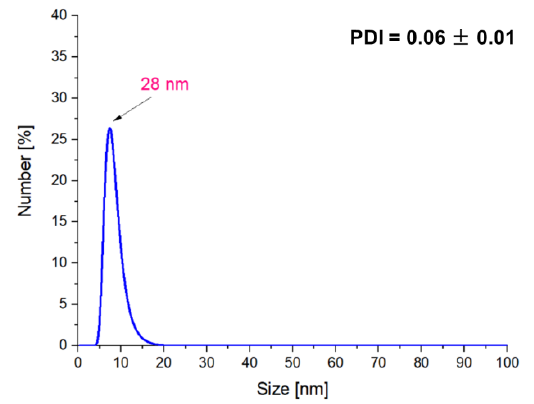
Figure 8. DLS measurements of the Fe 3 O 4 @Ag particles after 2 h of sonication.